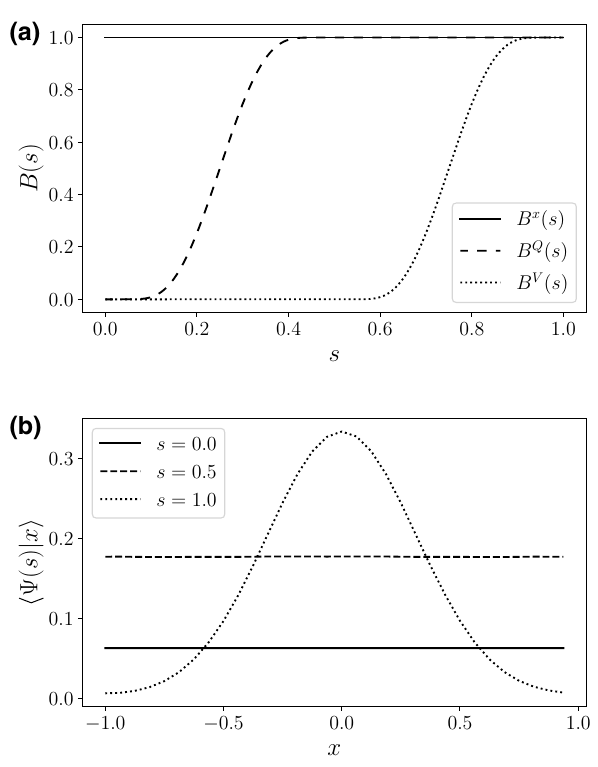
FIG. 10. (a) The time-dependent coefficient B x ( s ) for the transverse Hamiltonian H x , B Q ( s ) for the penalty Hamiltonian (cid:21) Q P ( c ) , and B V ( s ) for the potential. (b) The ground-state c eigenvector of H ( s ) for when (solid line) s = 0 and the system is governed by H x , (dashed line) s = 0.5 when the system is the H2GC Laplacian, and (dotted line) s = 1 where the harmonic oscillator potential is present.